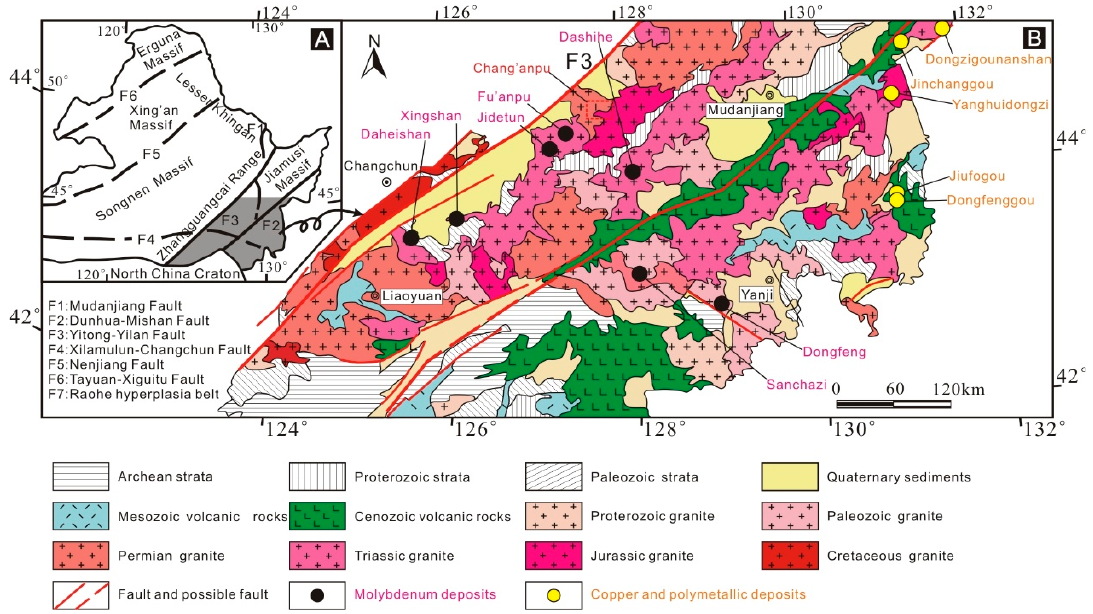
Figure 1. Simplified tectonic map ( A ), and geological map ( B ), of the Chang’anpu Mo deposit and adjacent areas (Modified after Han et al., 2013) [40] .